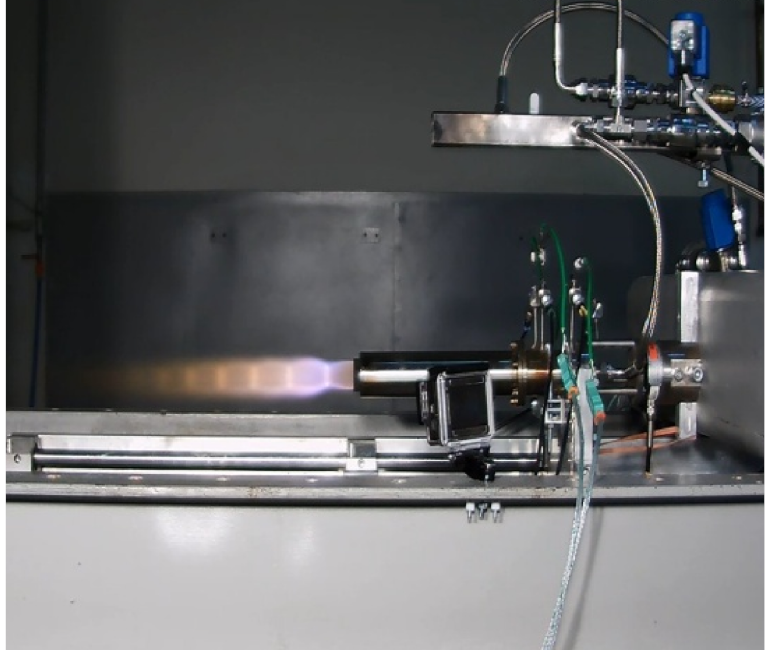
Figure 5. Hot-firing of laboratory hybrid rocket motor, which was used for regression rate characteri- zation of several solid fuels with 98% HTP before propellant trade-off finalization for the core hybrid stage of the ILR-33 AMBER suborbital rocket.